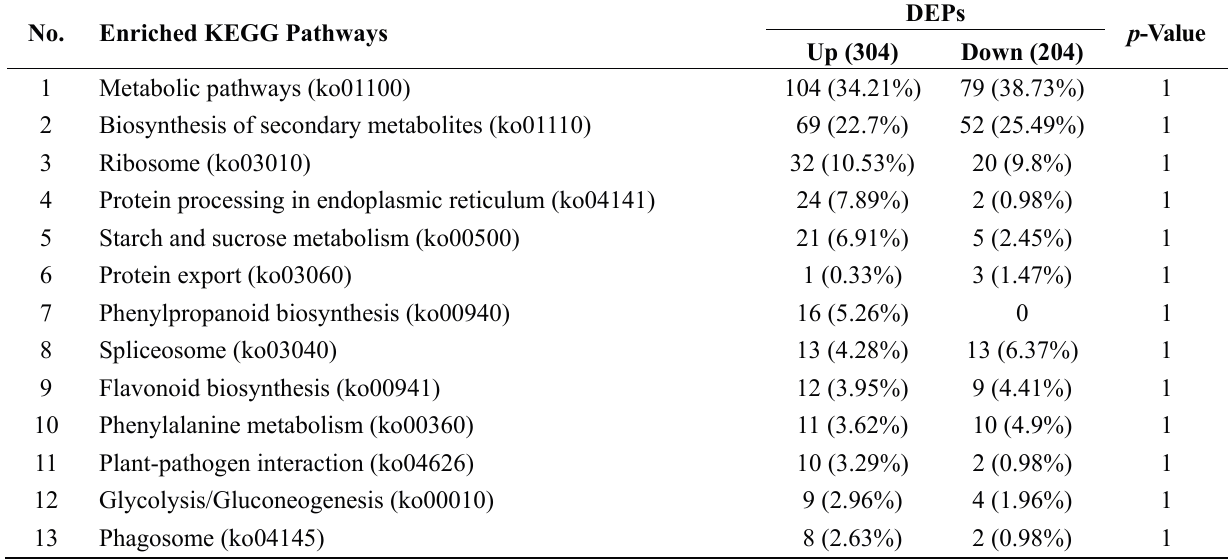
Table 1. Kyoto Encydopedia of Genes and Genomics (KEGG) pathways of Differentially Expressed Proteins (DEPs) during the response of G. thurbri to V. dahliae